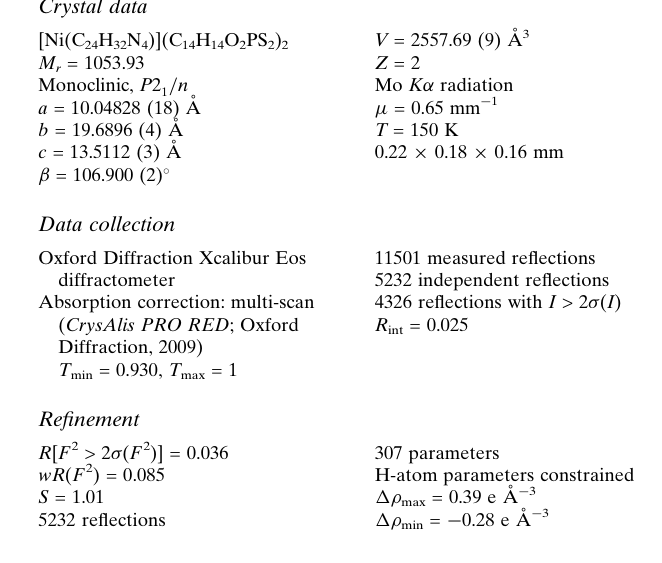
11501 measured reflections 5232 independent reflections